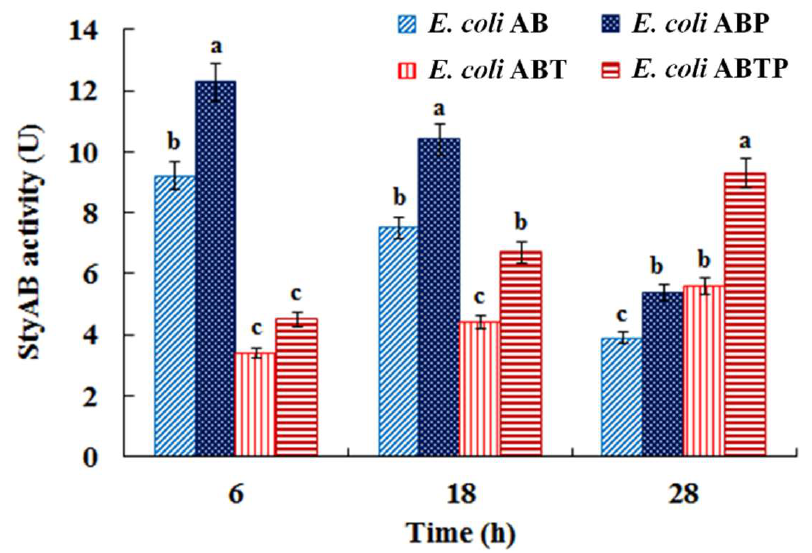
Figure 7. StyAB activity in E. coli AB, E. coli ABP, E. coli ABT, and E. coli ABTP in fermentation with 1.2 mg/mL of tryptophan. Bars with different letters (a, b, and c) are significantly different ( p < 0.05).